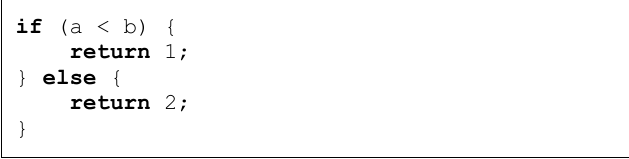
Fig. 6. First branching example decompilation result.